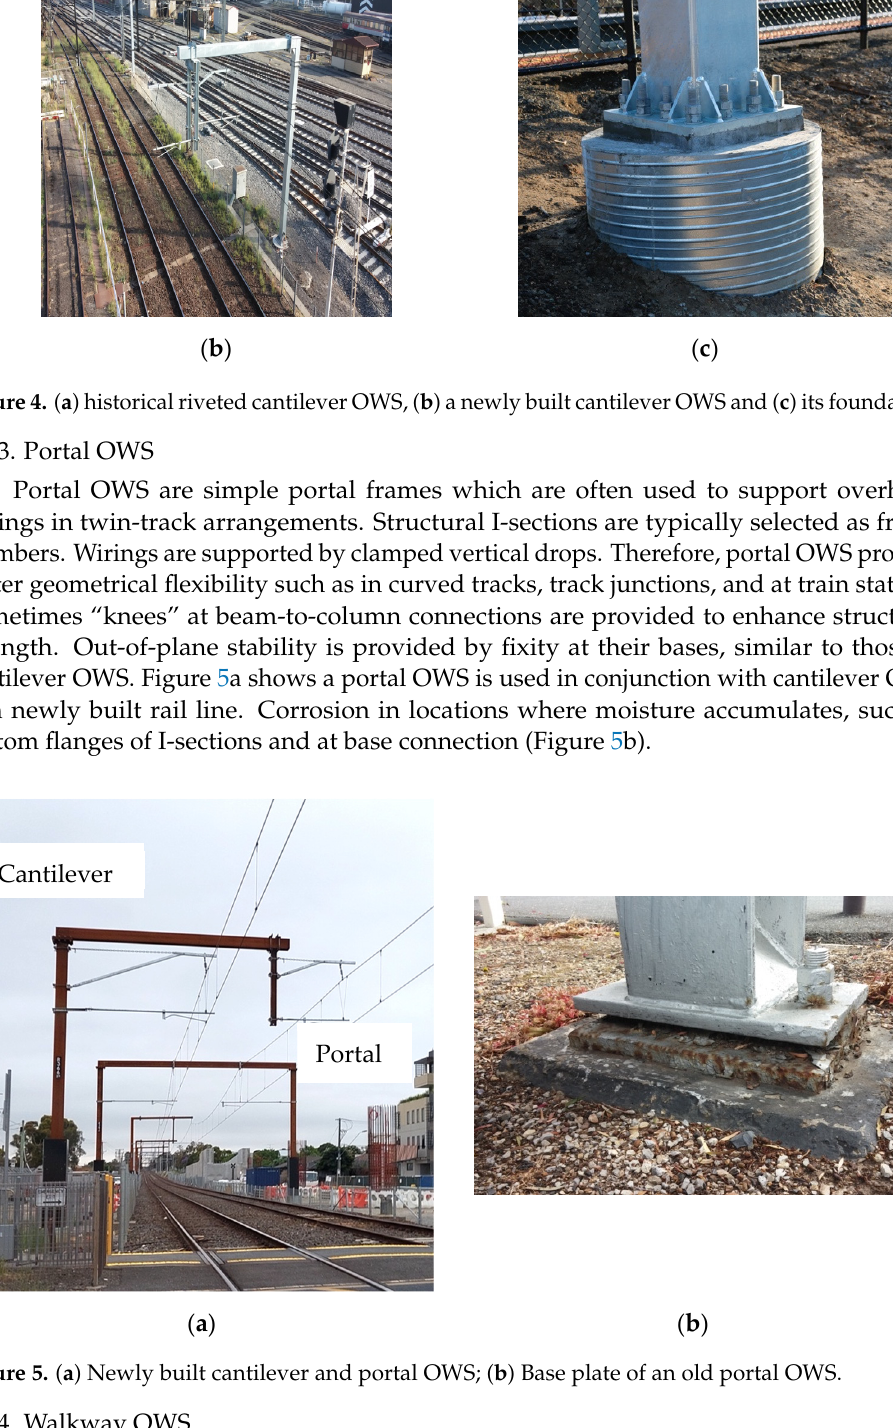
Figure 5. ( a ) Newly built cantilever and portal OWS; ( b ) Base plate of an old portal OWS.